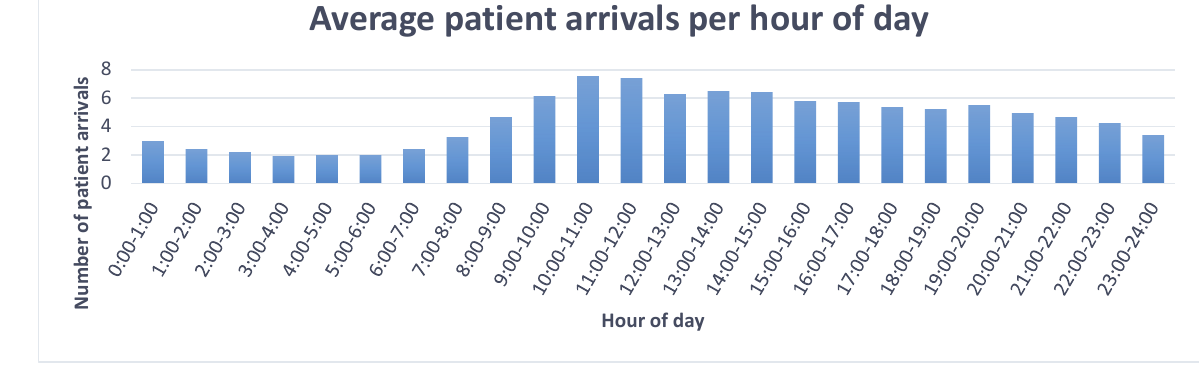
Fig. 4 . Average patient arrivals per hour of day